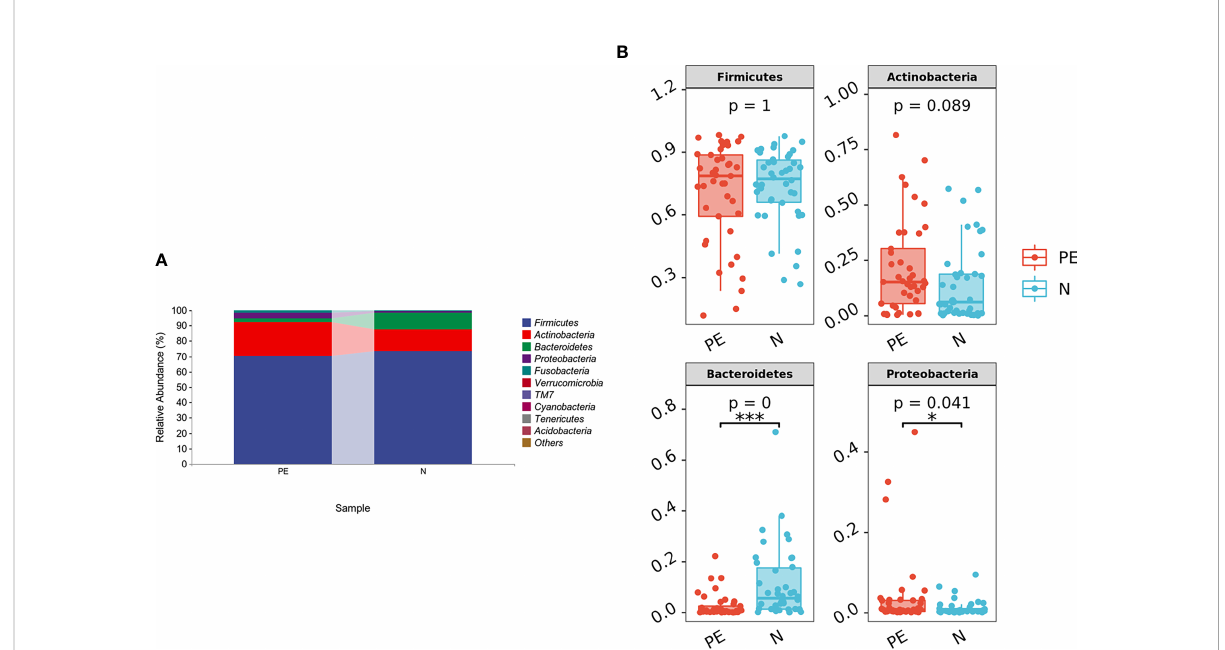
FIGURE 1 The distribution of gut microbiota at the phylum level in the different groups. The top 10 bacteria (A) and top 4 bacteria (B) at the phylum level of each group were showed. PE, preeclampsia; N, the normal group. *P < 0.05, ***P <